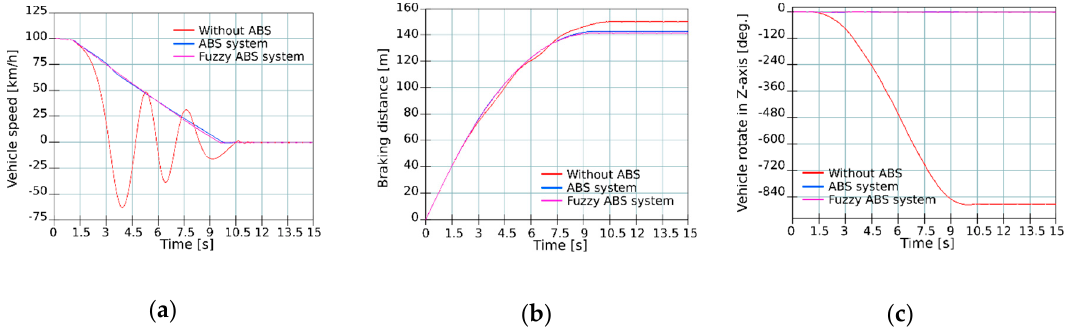
Figure 12. Test on road with combined adhesion at speed 100 km/h—( a ) Speed curve; ( b ) Braking distance; ( c ) Vehicle rotation. Table 5. Test results on road with combined adhesion at speed 100 km/h.